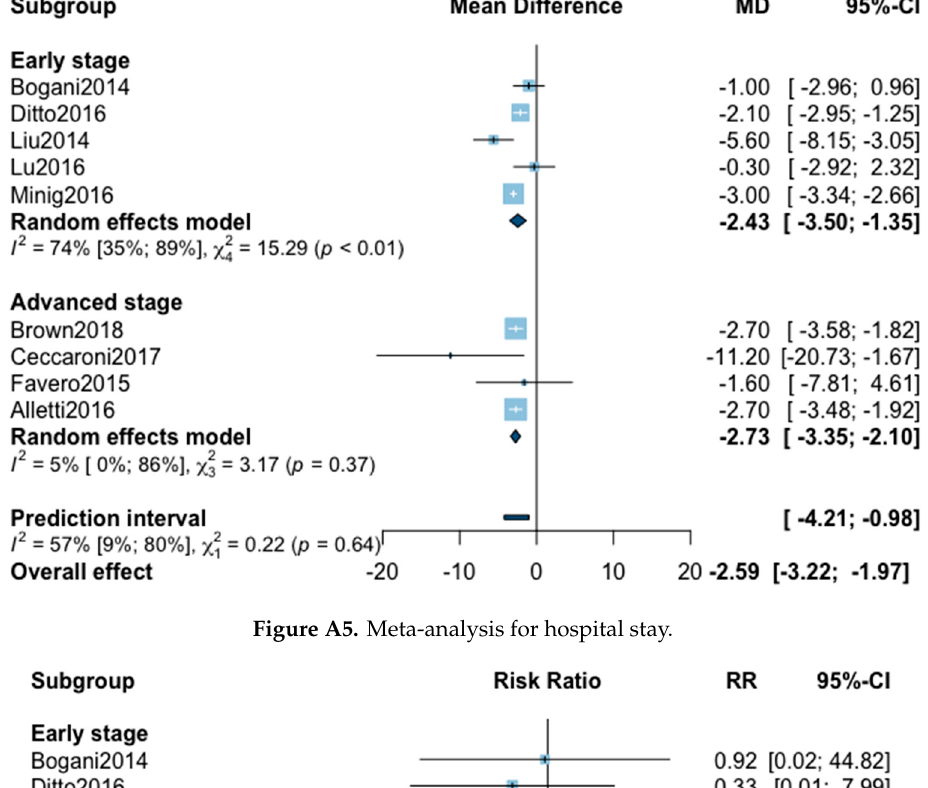
Figure A5. Meta ‐ analysis for hospital stay .